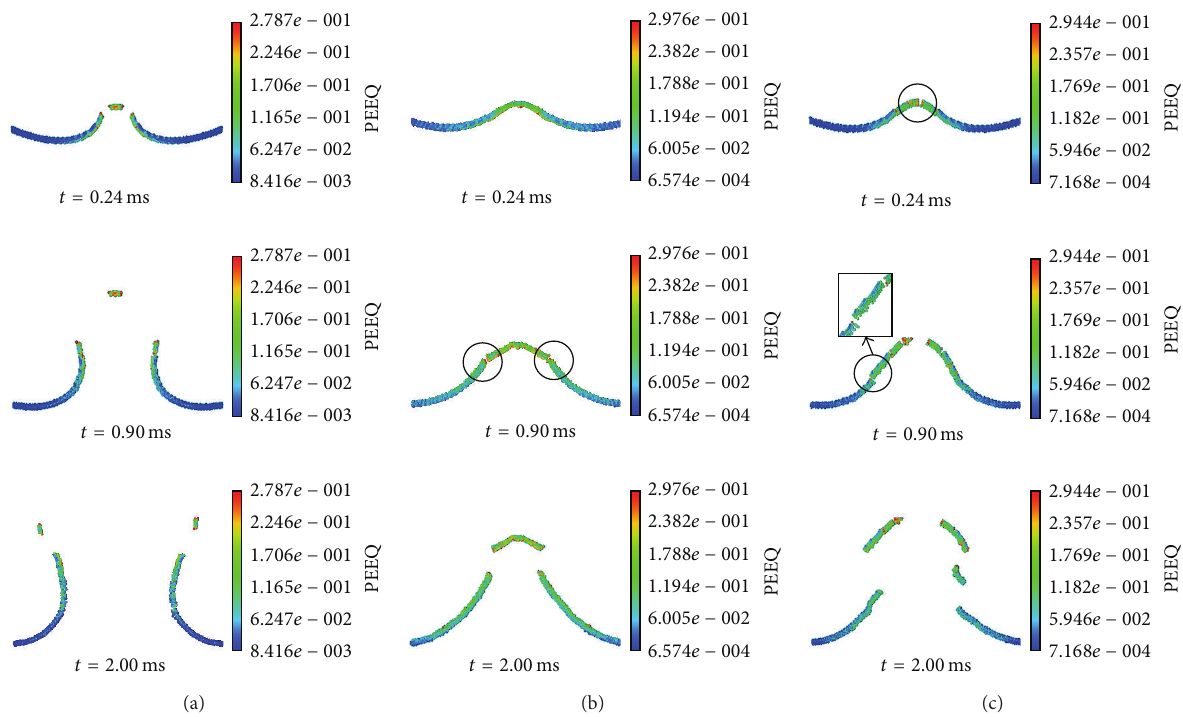
Figure 8: The equivalent plastic strain of coated shell; (a), (b), and (c) correspond to no-covering, in-covering, and out-covering,